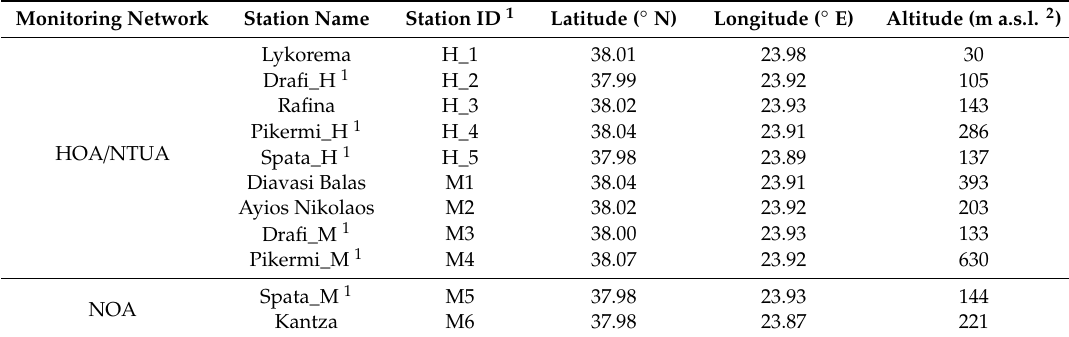
Table 1. Key characteristics of the ground-based observational